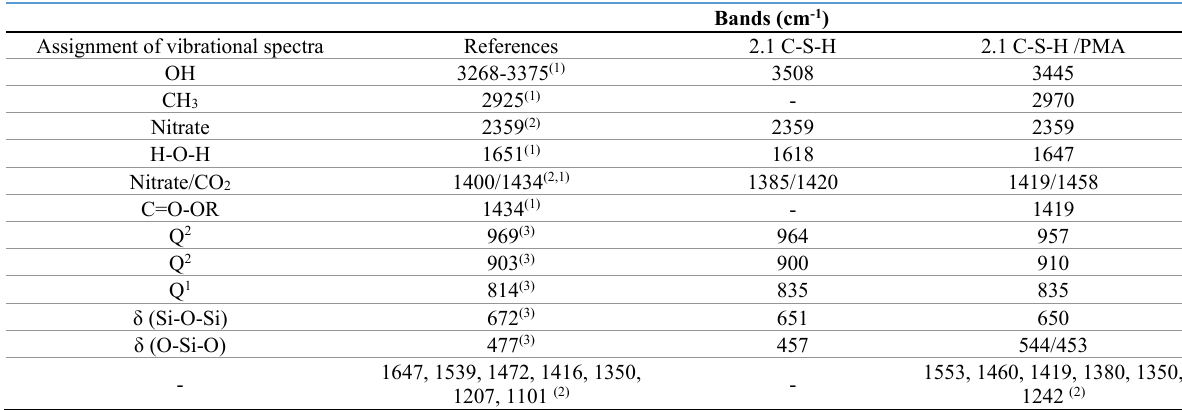
Figure 2. FT-IR spectra of C-S-H and C-S-H/PMA. Table 2. Selected FT-IR bands of C-S-H and